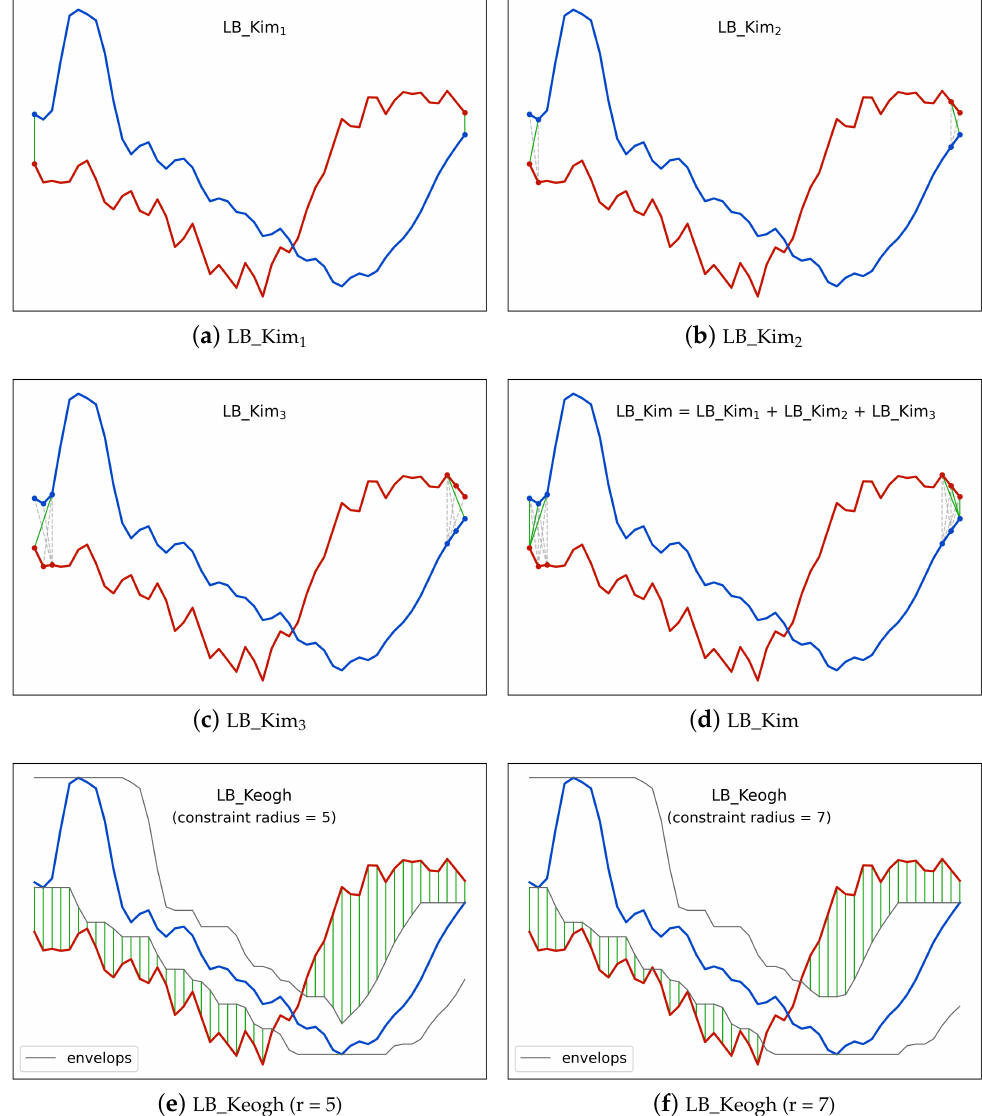
Figure 3. Examples of LB_Kim and LB_Keogh . LB_Kim is composed of three parts. LB_Keogh is related to the radius of the Sakoe–Chiba band of DTW because different radius lead to different envelopes of the time